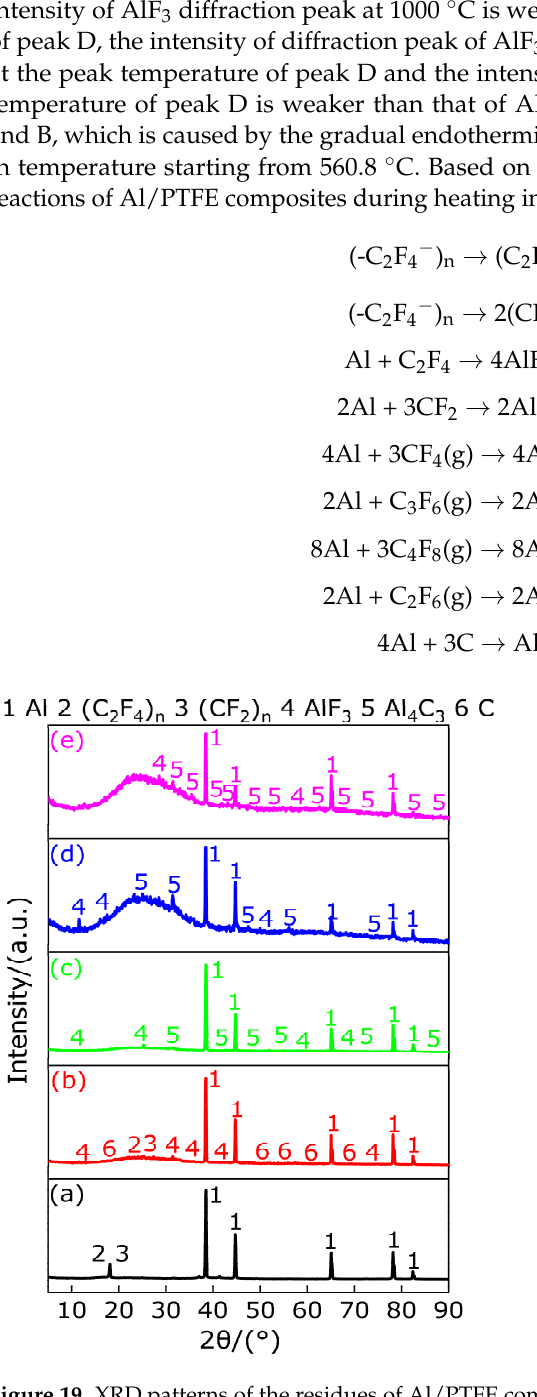
Table 18. Products of Al/PTFE composites in different temperature ranges under argon atmos- phere. Temperature/(°C)